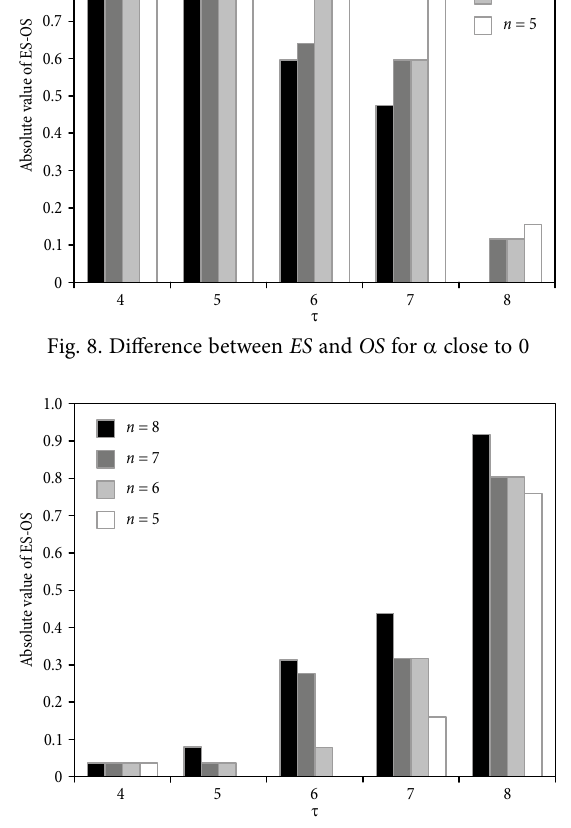
Fig. 9. Difference between ES and OS for 10 a >